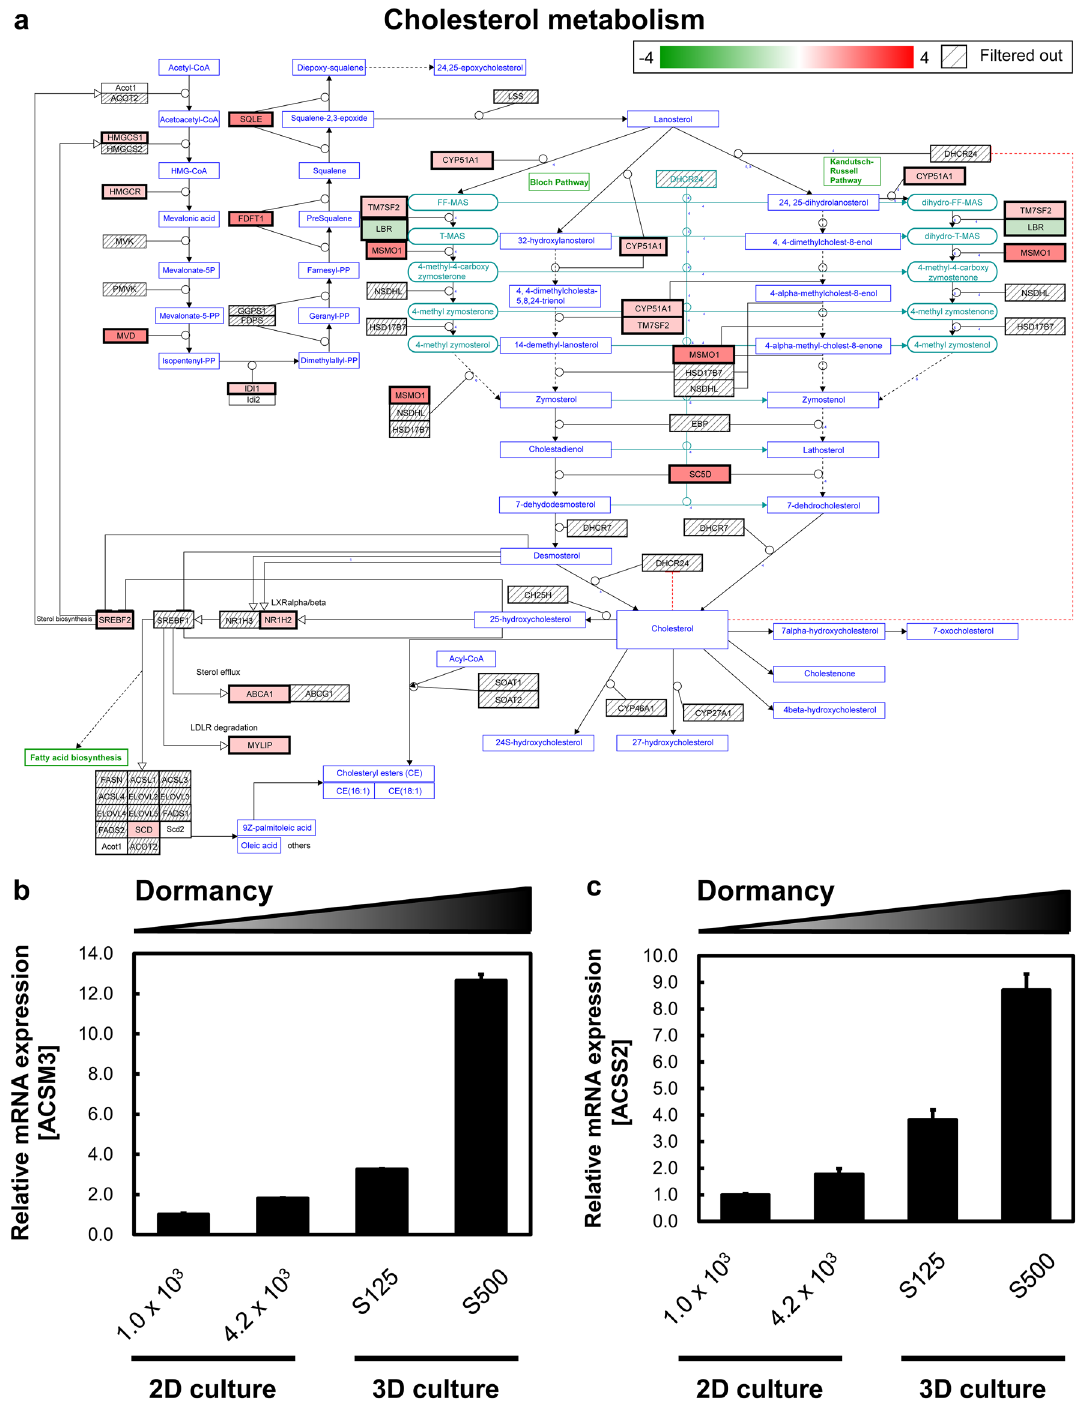
Figure 2. Lipid metabolisms change in dormant cancer cells. ( a ) Cholesterol metabolism involved in 3D cultured S500 and S125 spheroids. S500 spheroids displayed higher cholesterol metabolism than S125 spheroids. Genes were selected from the “Cholesterol metabolism (includes both Bloch and Kandutsch–Russell pathways) (Homo sapiens)” pathway according to Wikipathways. Red indicates increased expression, and green denotes decreased expression. ( b ) The mRNA expression of acyl-CoA synthetase medium chain family member 3. ( c ) The mRNA expression of acyl-CoA synthetase short-chain family member 2. All mRNA expression analyses were conducted using Transcriptome Analysis Console ver. 4.0.1.36. Genes with changes in expression exceeding 1.5-fold and significant at p < 0.05 genes were extracted. n =